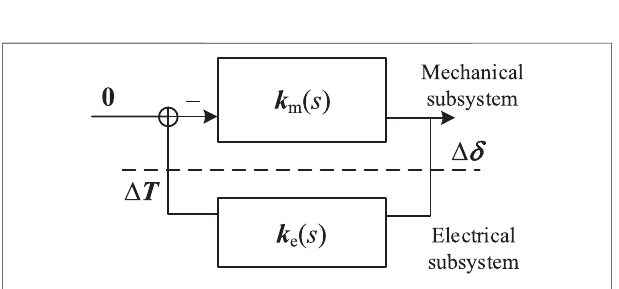
FIGURE 3 | Closed-loop interconnected mode of mechanical and electrical subsystems of power system with N integrated PMSGs.